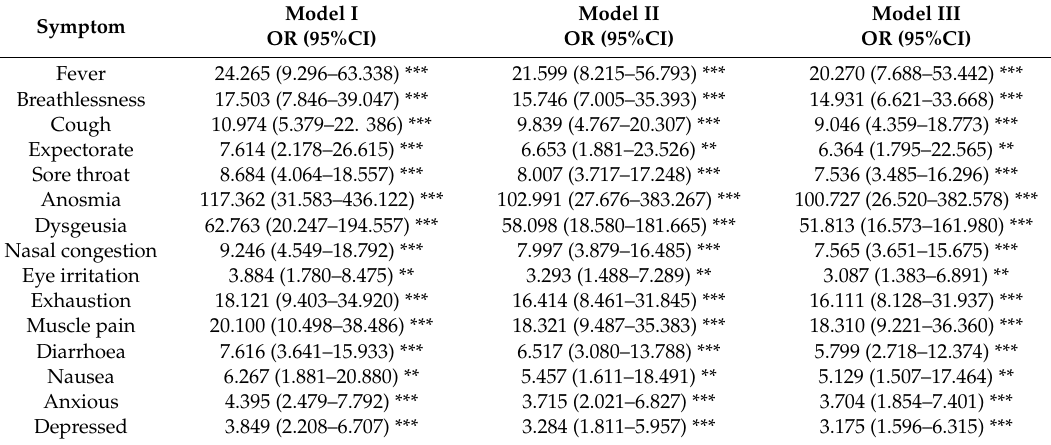
Table 5. Multivariate logistic regression